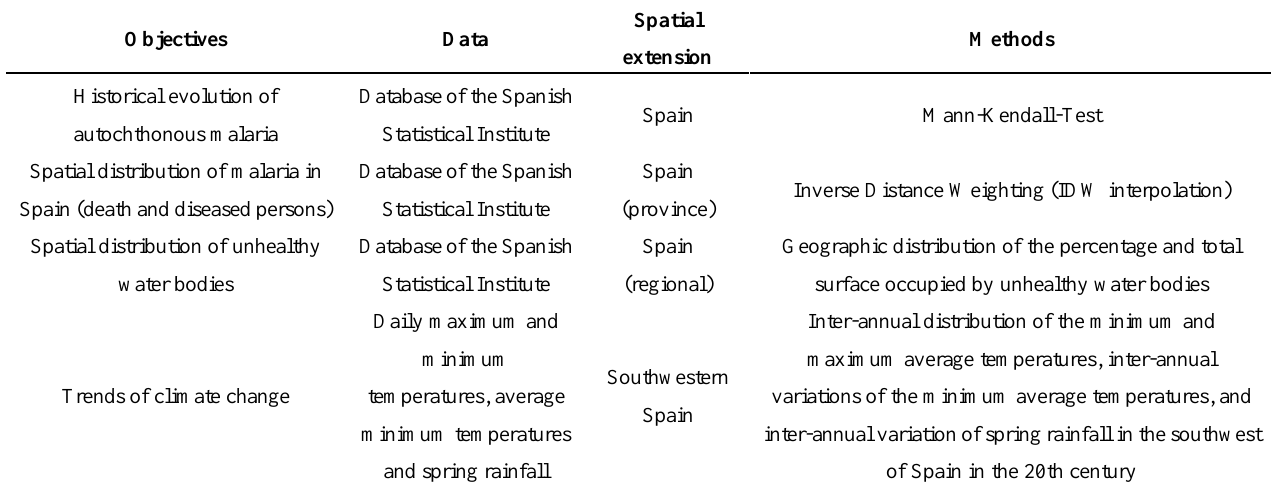
Table 1. Overview of the applied methodology and data of the